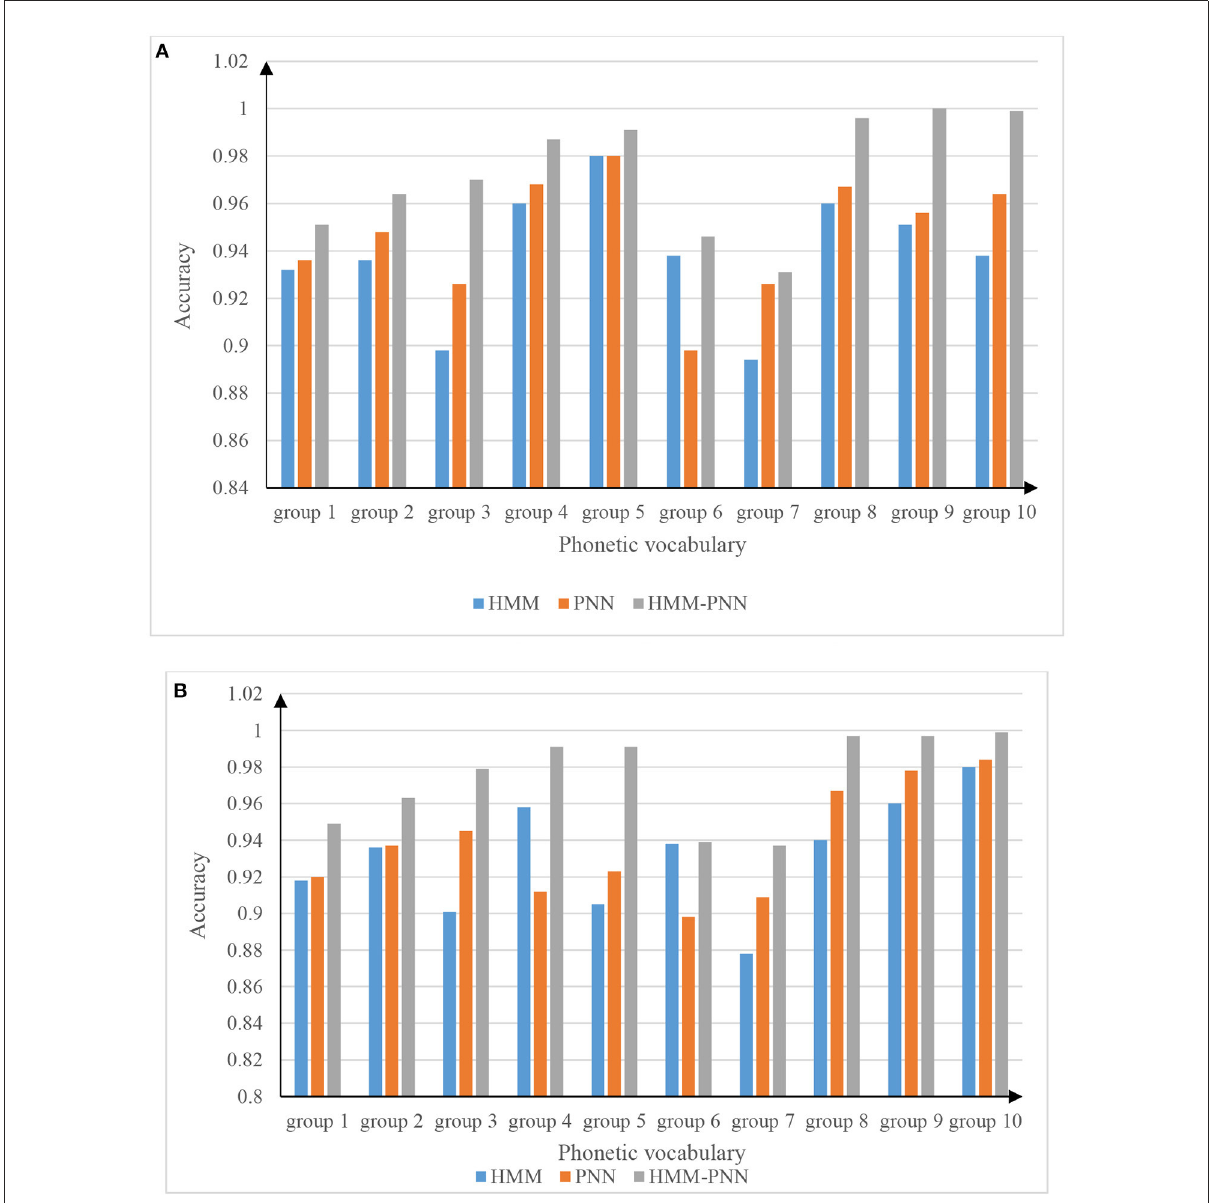
FIGURE6 The accuracy of speech recognition for boys and girls. (A) Accurate picture of male voice recognition. (B) Accurate picture of girls’ voice